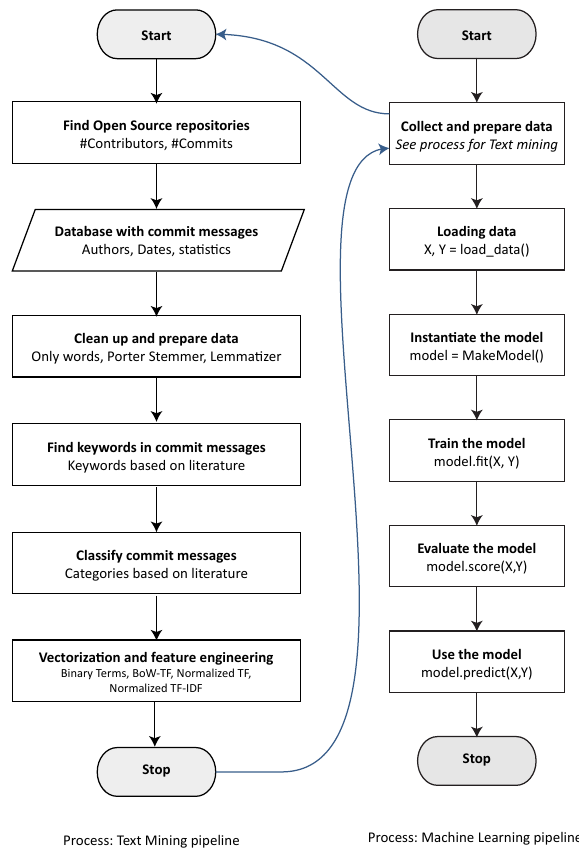
Figure 7. Pipelines for Text Mining and Machine Learning